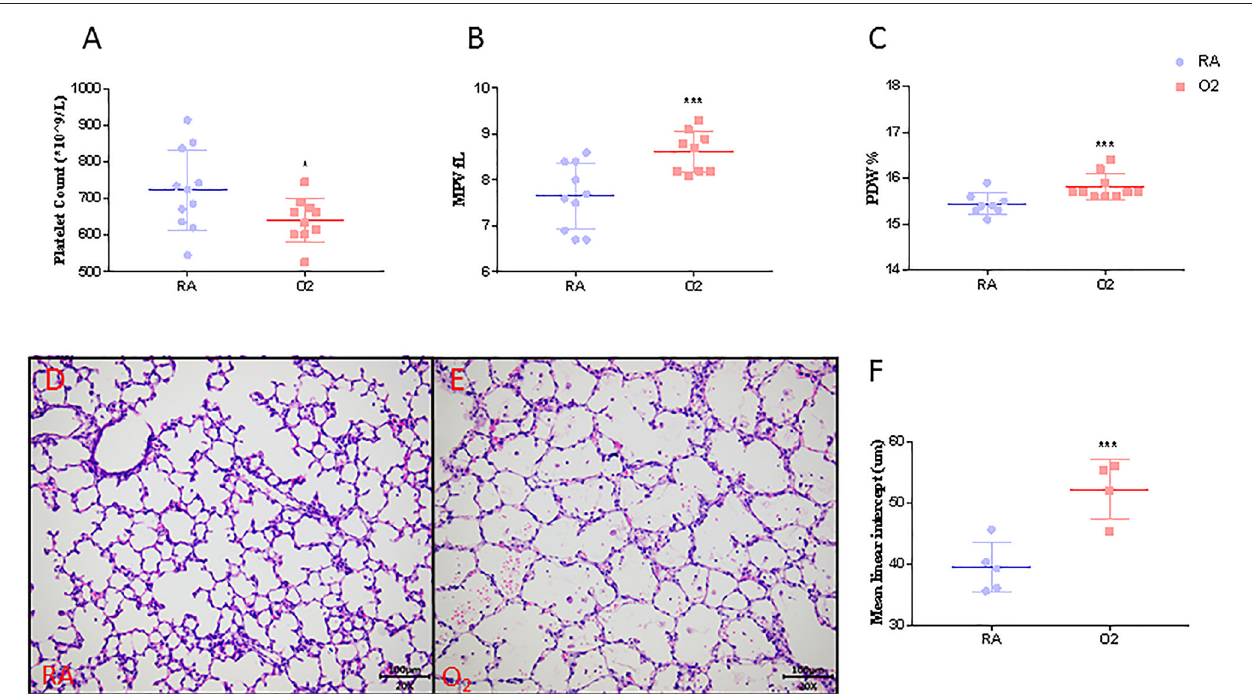
FIGURE 3 | Platelet parameters ( N = 9–10, A–C ), mean linear intercept (MLI, N = 4–5, F ) and representative photos of rat pups exposed to room air (RA, D ) or hyperoxia (O 2 , E ) at postnatal Day 10. Values are expressed as mean ± SD. * p < 0.05, *** p < 0.001, compared with age-matched RA controls using the student t -test. Magnification, 200